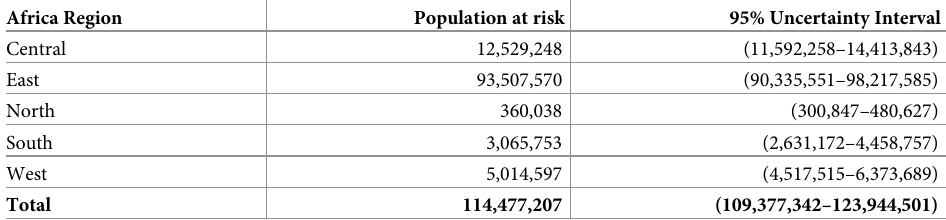
Table 1. Estimates of population living in areas environmentally suitable for podoconiosis in Africa. Estimates were obtained from a gridded map of population density for 2020 (www.worldpop.org).